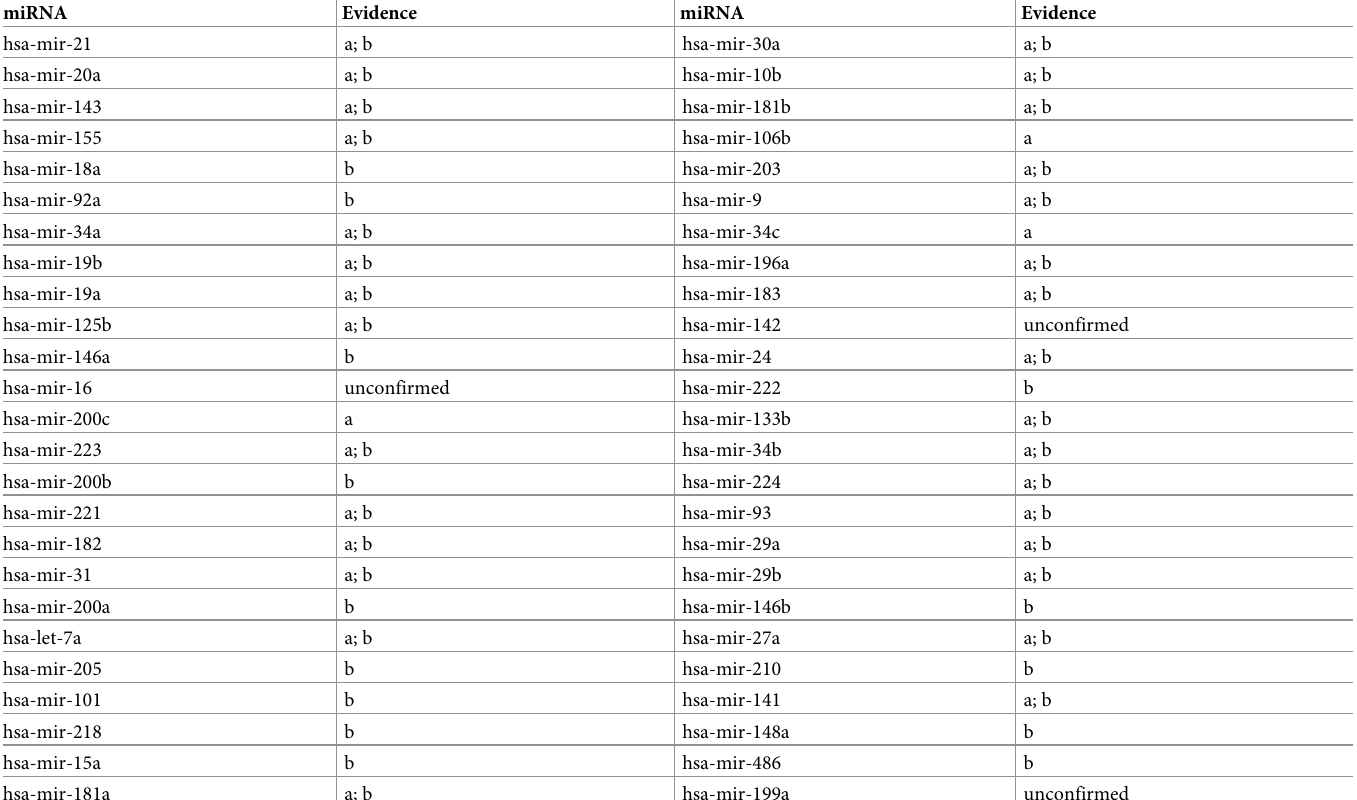
Table 2. The top 50 potential miRNAs associated with colon neoplasms. miRNA Evidence miRNA